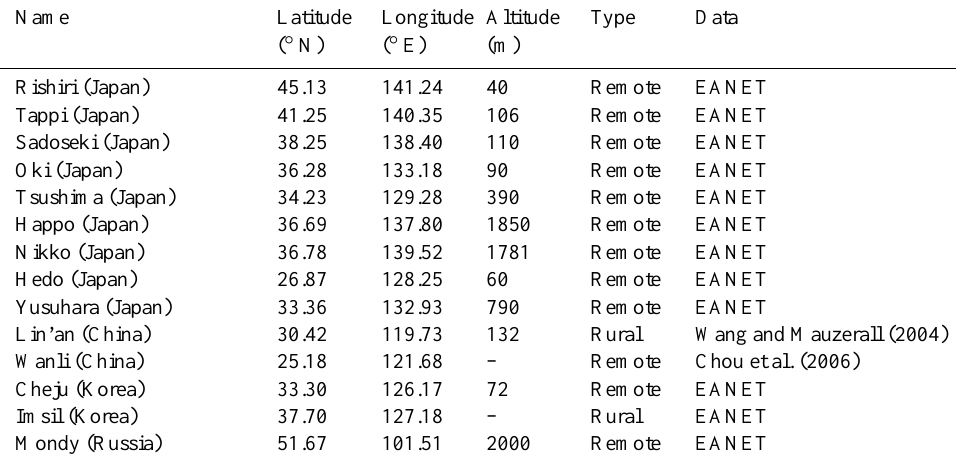
Table 6. Description of observational sites.